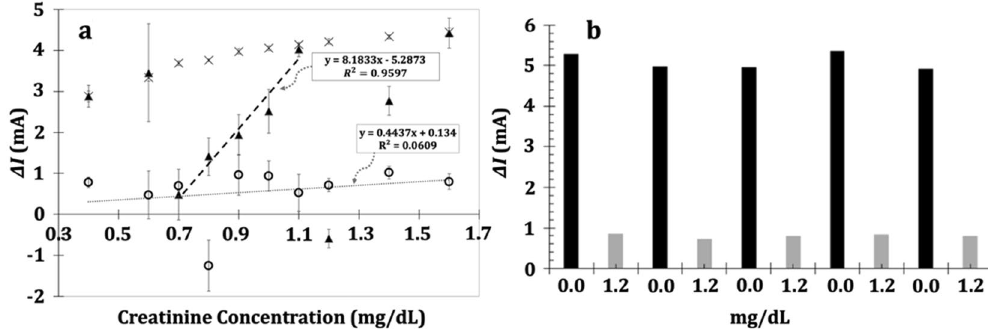
Figure 8. ( a ) The calibration curves obtained from the 3BOBzBT 2 :5CHCl 3 -sensor ( X ), 1BOBzBT 2 :2CHCl 3 - sensor (black filled triangle), and the unmodified-sensor (open circle). The thick dashed line represents the linear regression for 1BOBzBT 2 :2CHCl 3 -sensor while the thin dotted line represents the attempted linear regression for the unmodified-sensor. ( b ) Reproducibility bar obtained by recording in repetition, the peak output currents of blank solution (0.0 mg dL −1 ; black bar) and the creatinine concentration of 1.2 mg dL −1 (grey